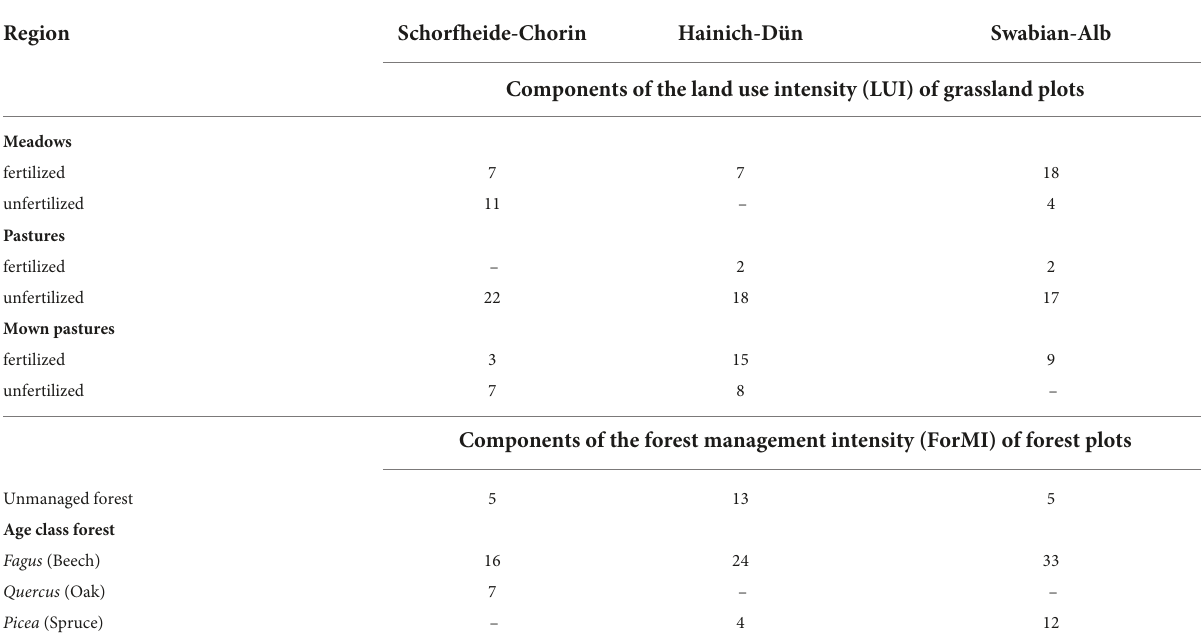
TABLE 1 Number of individual plots with contrasting land-use and management types for grassland and forest habitats in three regions. Region Components of the land use intensity (LUI) of grassland plots